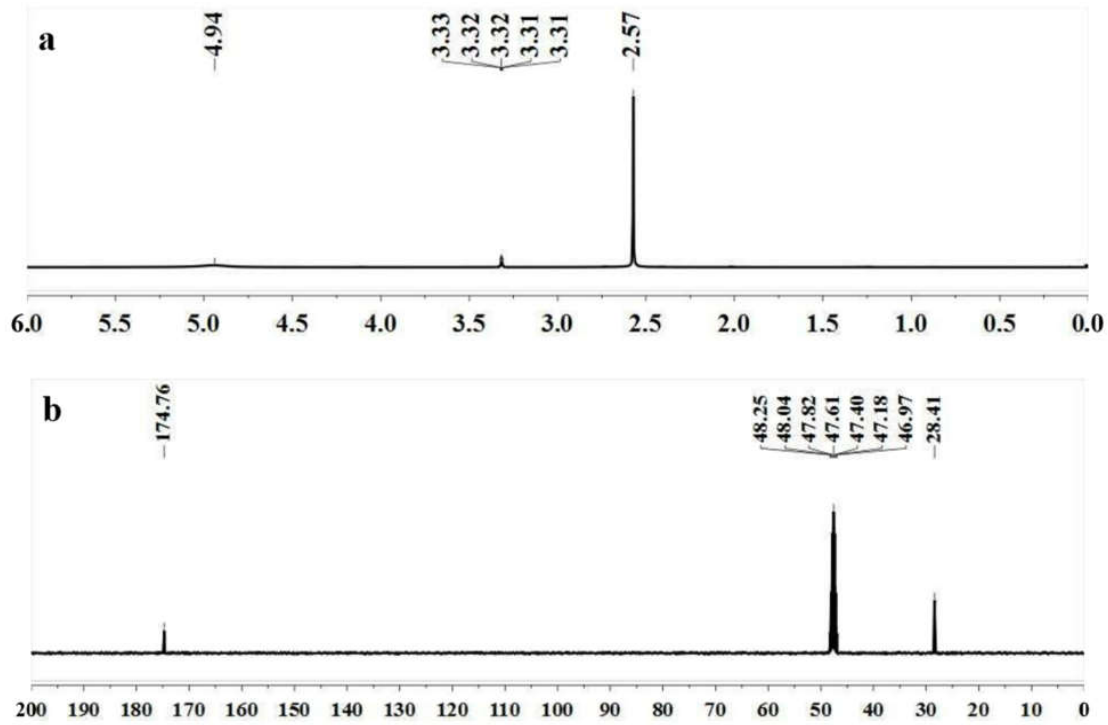
Figure 4. 1 H NMR ( a ) and 13 C NMR ( b ) spectra of Fr 3.